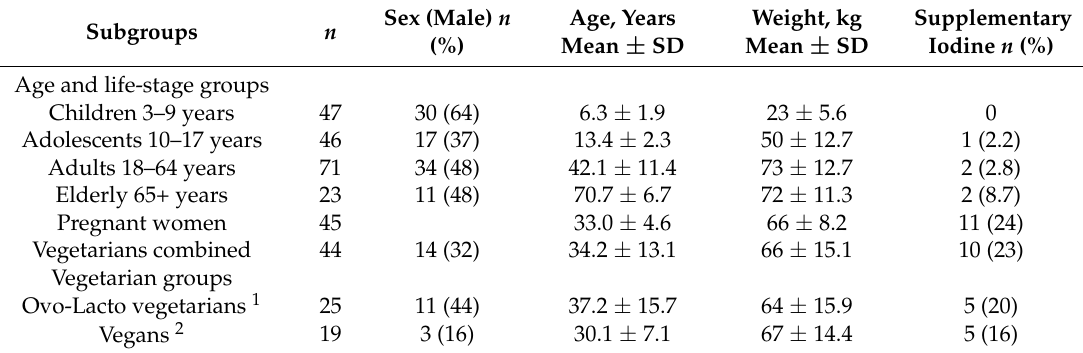
Table 1. Characteristics of the study population by non-overlapping subgroups, total n =